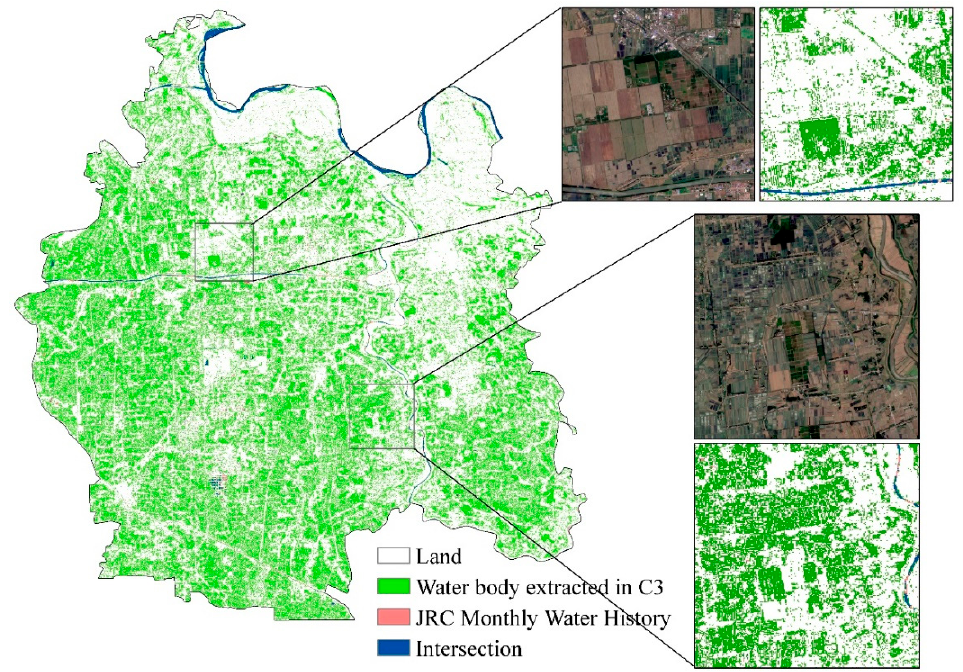
Figure 8. Comparison with a current water body product. The spatial distribution of the difference between experiment C3 and JRC Monthly Water History.